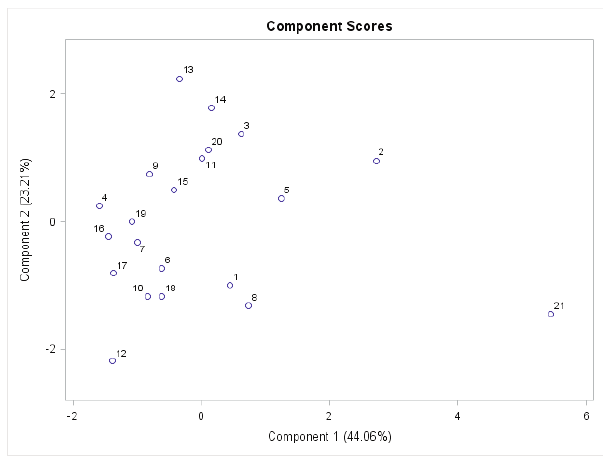
Fig. 2 ­ Principal components score plot for 21 Amaranthus